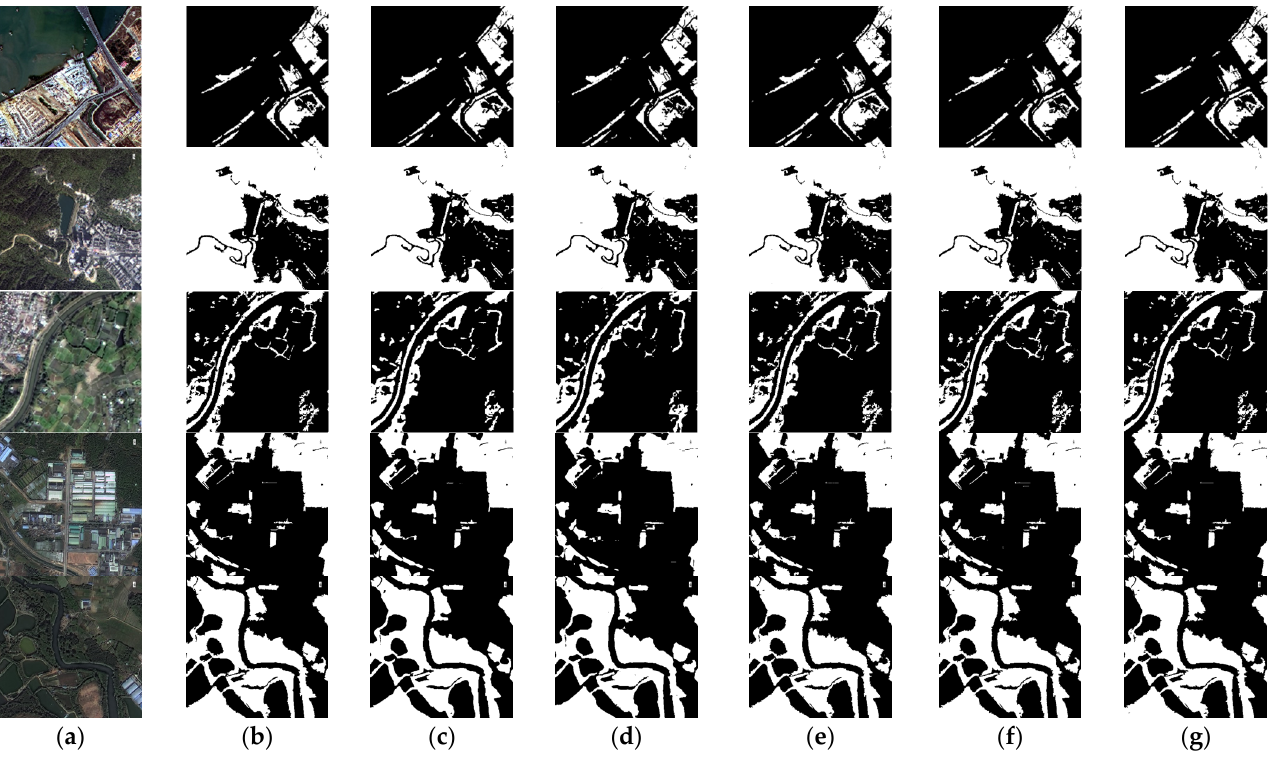
Figure 9. The results classified by the five CNNs on the test set. ( a ) The original images; ( b ) Corresponding labels; ( c ) The predicted maps of FCN8s, ( d ) The predicted maps of DeepLabV3+; ( e ) The predicted maps of UNet; ( f ) The predicted maps of CRUNet; ( g ) The predicted maps of CRAUNet.